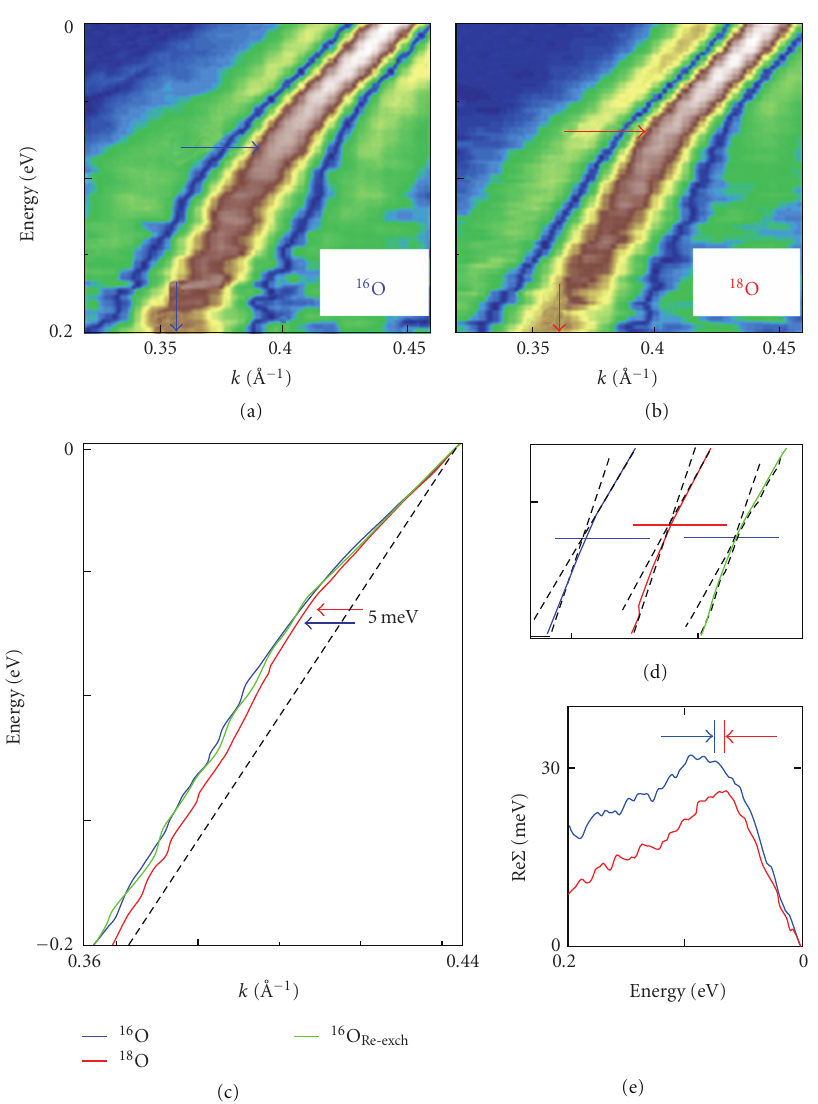
Figure 6: (a-b) MDC maps of the nodal point electronic states for cuts along the Γ - Y direction. (a) The 16 O sample and (b) the 18 O substituted sample with the horizontal arrows indicating the shift in ARPES kink energy with oxygen isotope. (c) The MDC dispersions determined from the 16 O, 18 O, as well as a resubstituted 16 O samples for the cuts in (a-b). (d) Cartoon illustration of the kink shift in (c). (e) Real part of the electron self-energy, Re Σ ( k , ω ), determined from the MDC dispersion using a linear approximation for the single electron bare band. As before, the ARPES kink position, defined by the peak in Re Σ ( k , ω ), is shifted to higher energy as indicated by the